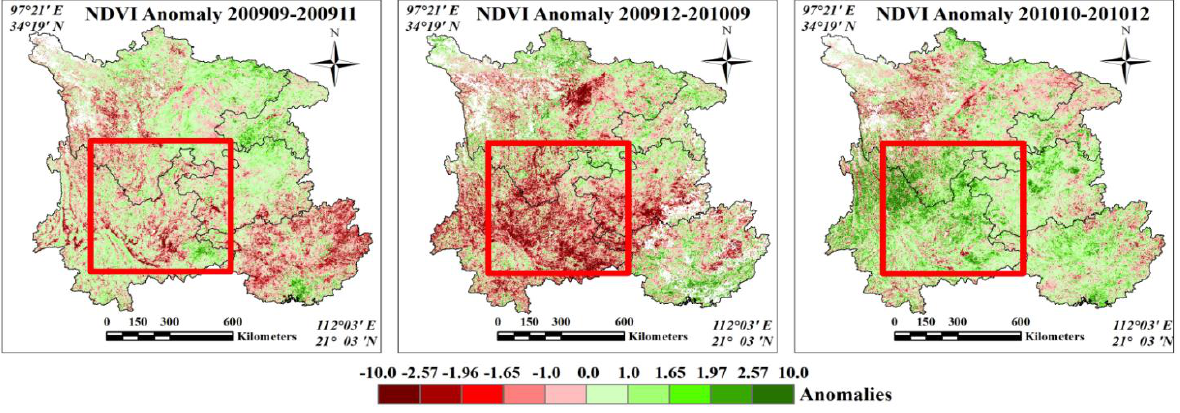
Figure 4. Natural vegetation NDVI anomaly spatial distribution in the three time periods: initial stage ( left ), middle stage ( middle ), and final recovery stage ( right